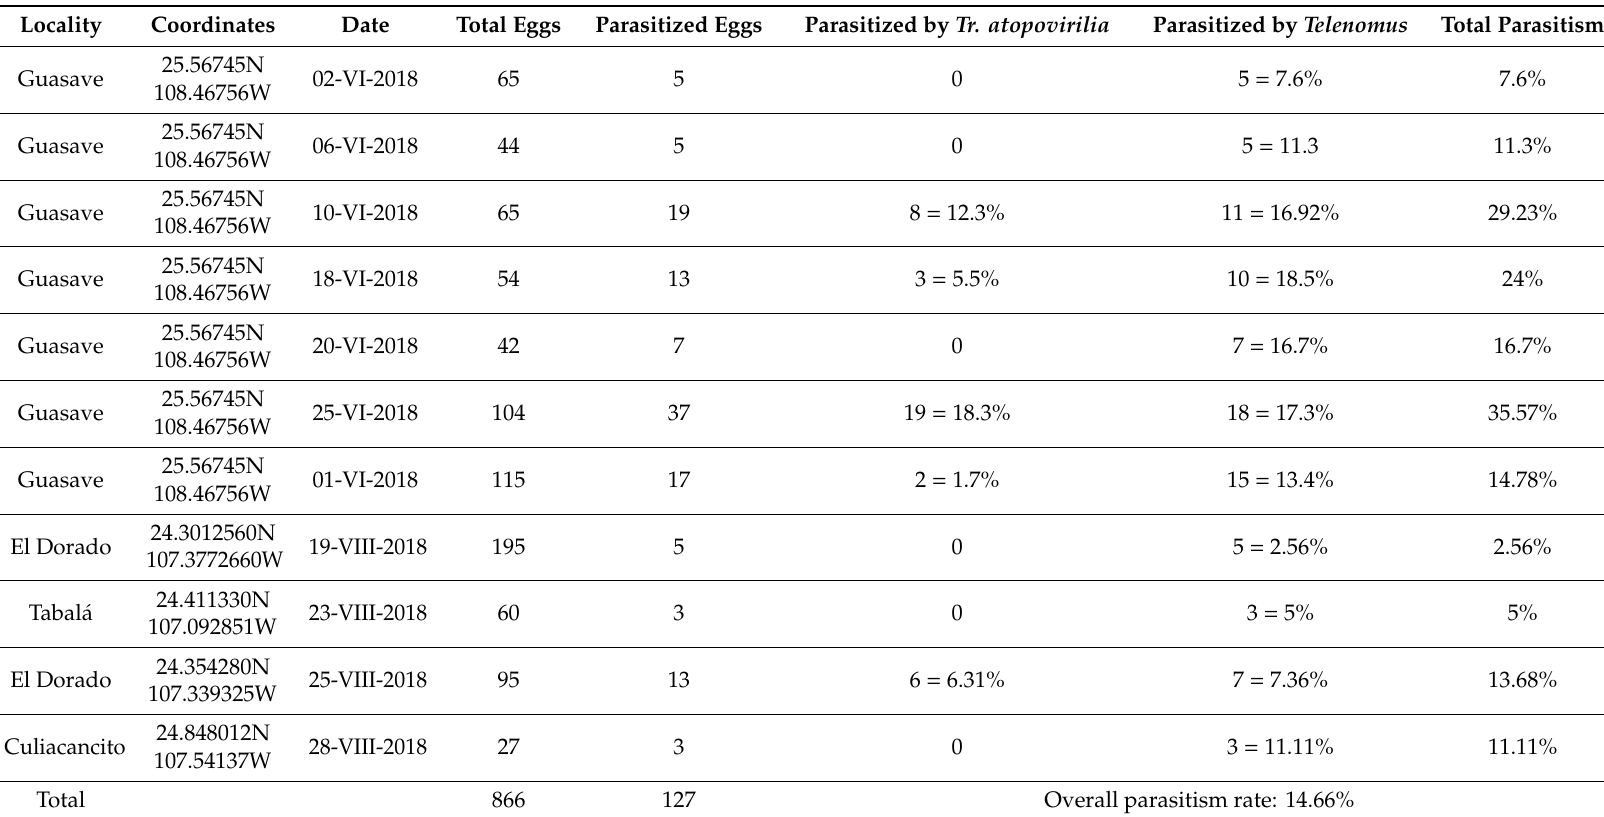
Table 1. Collection dates, localities, and number of chrysopid eggs collected in field surveys in Sinaloa during